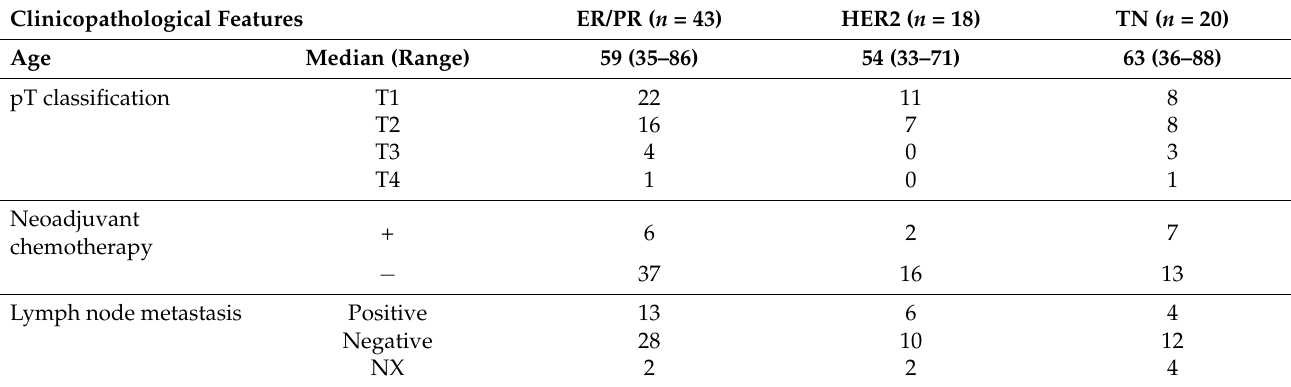
Table 1. Clinicopathological features in this